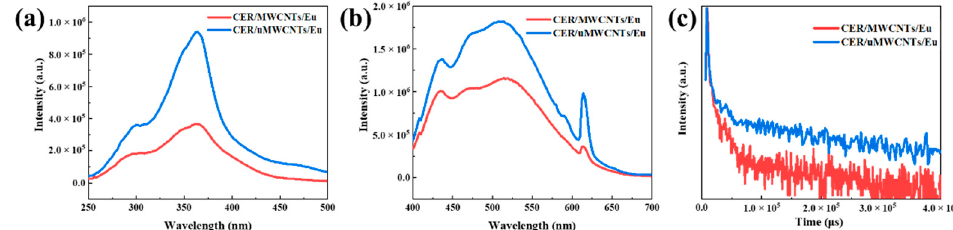
Figure 11. Luminescence excitation ( a ) and emission ( b ) spectra and luminescence decay curves ( c ) of CER/MWCNTs/Eu, CER/uMWCNTs/Eu nanocomposites. Inset shows changes Eu at λ ex = 364 nm, λ em = 614 nm, Scan Slit = 1.50.